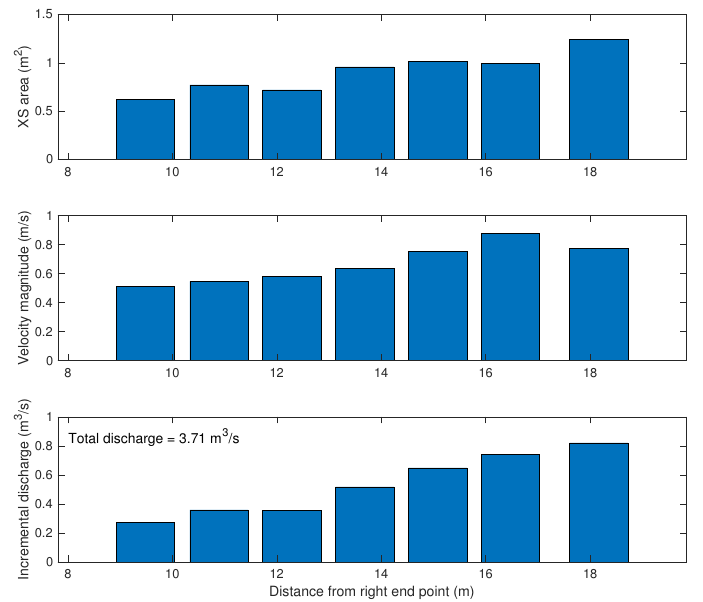
Figure 8. Illustration of how the cross sectional area associated with each vertical is multiplied by the corresponding velocity magnitude to yield a series of incremental discharges that are then summed laterally to obtain the total discharge. This example is based on remotely sensed data from cross section 1 on the Blue